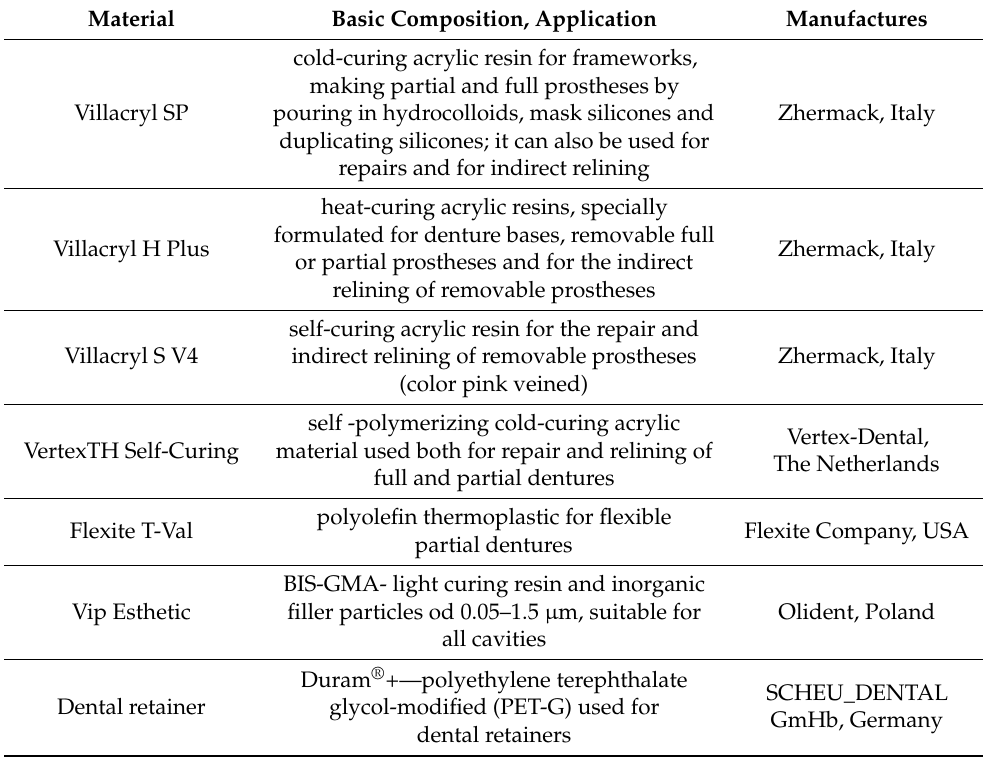
Table 1. Dental materials used in